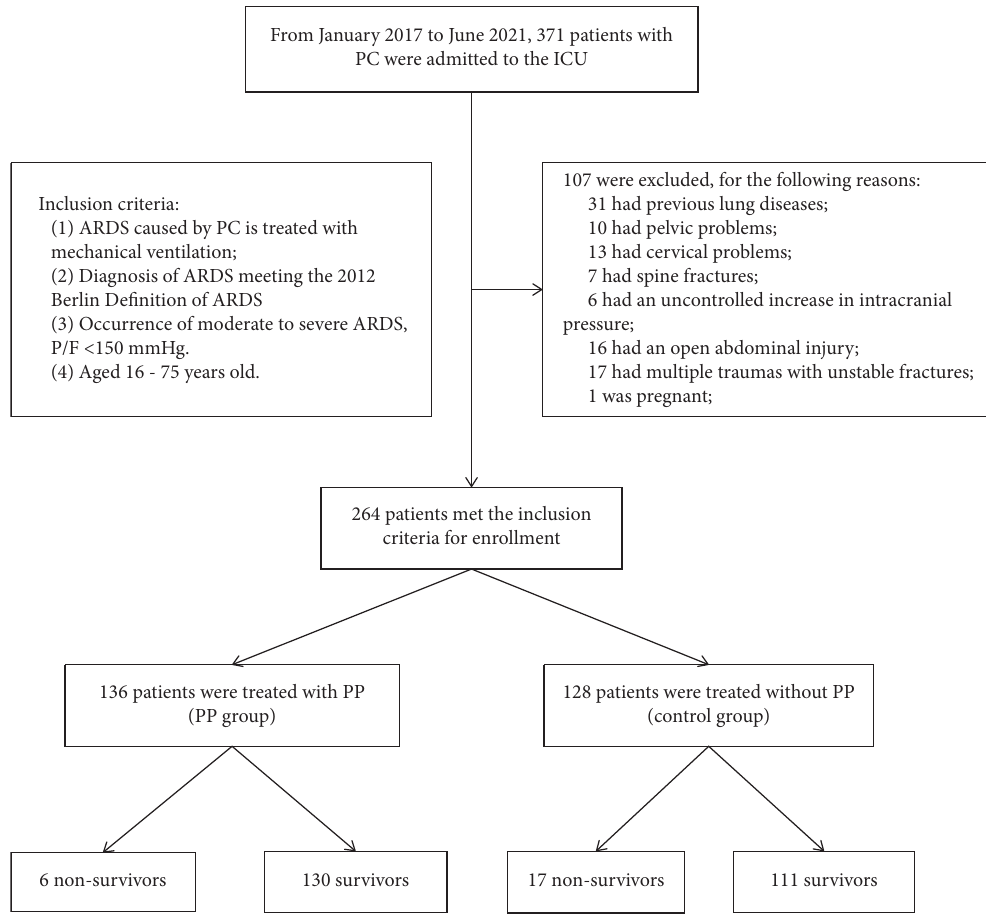
Figure 1: Patient-screening